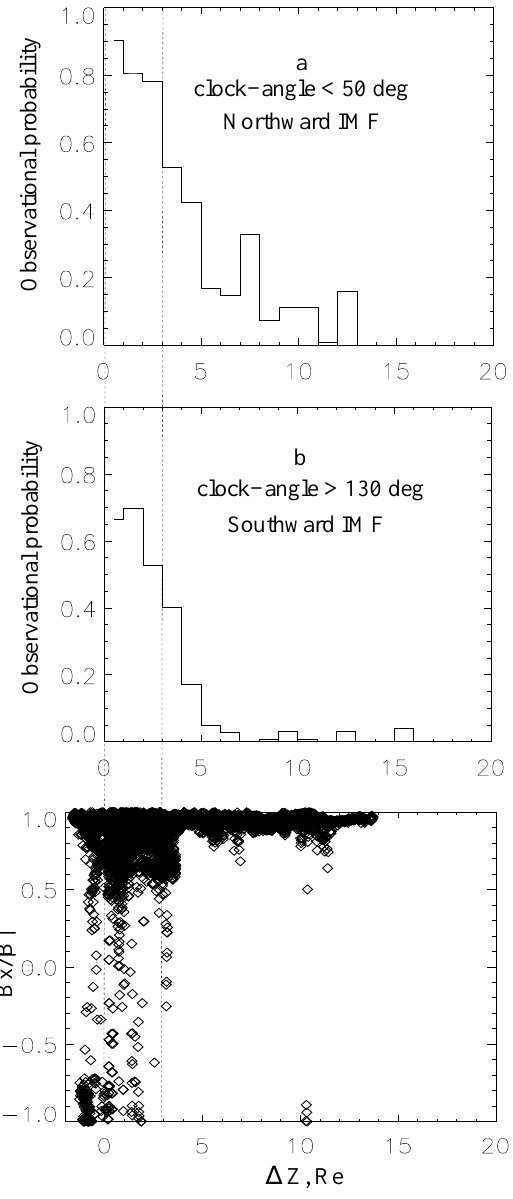
Fig. 9. Probability to observe PS-like structures versus 1Z for northward IMF (a) and for southward IMF (b) . The lower panel shows the scatterplot of B X / | B | to demarcate the PSt boundary which is shown by dashed vertical